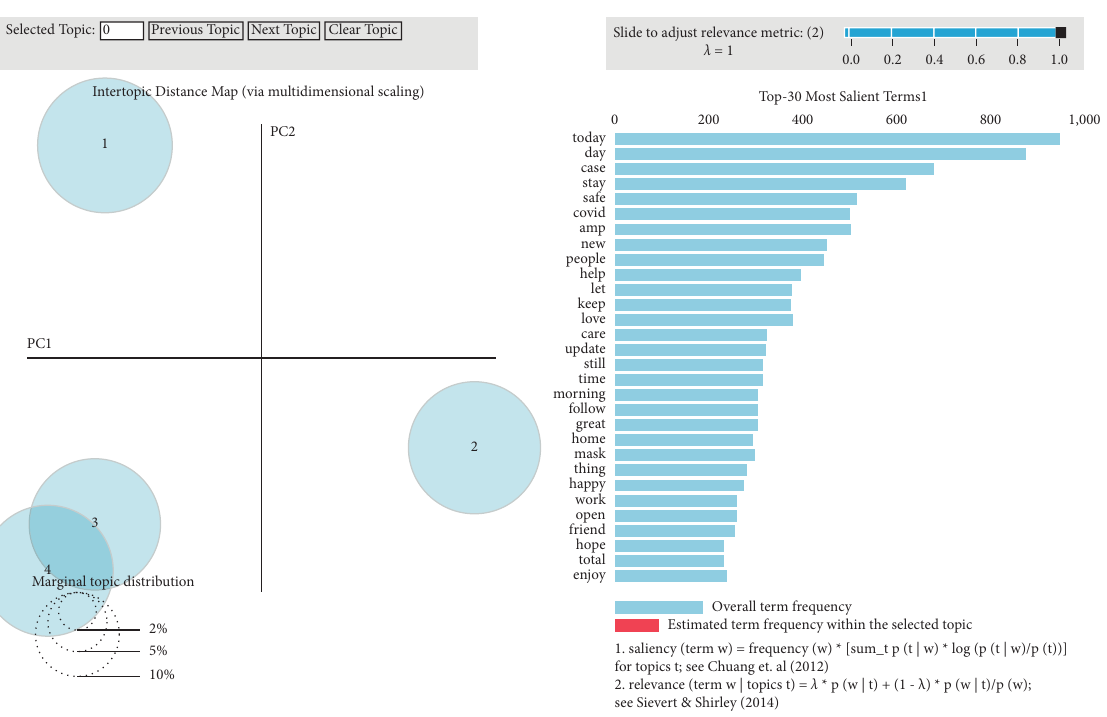
Figure 7: Intertypic distance map and Top 30 most relevant terms for topic 1 (25.1% of